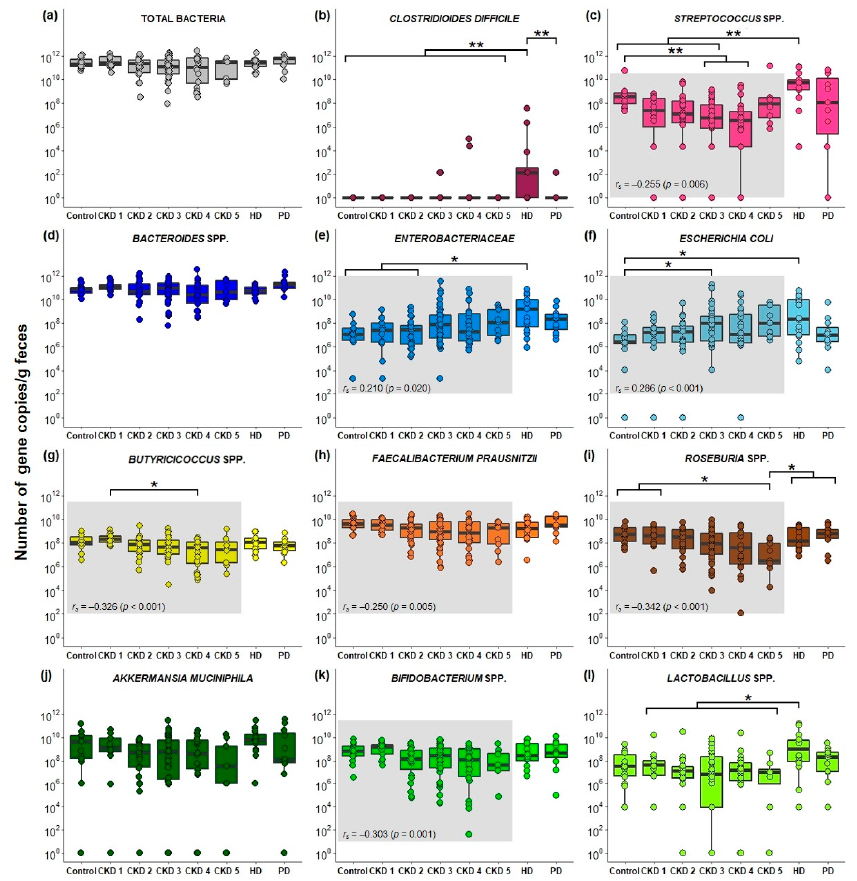
Figure 1. Bacterial gene copies per gram feces per chronic kidney disease (CKD) stage: ( a )